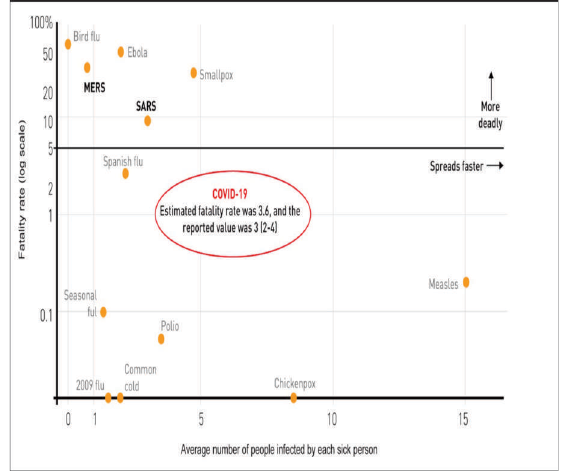
Figure 1. The CFR of COVID-19 compared to other known infectious